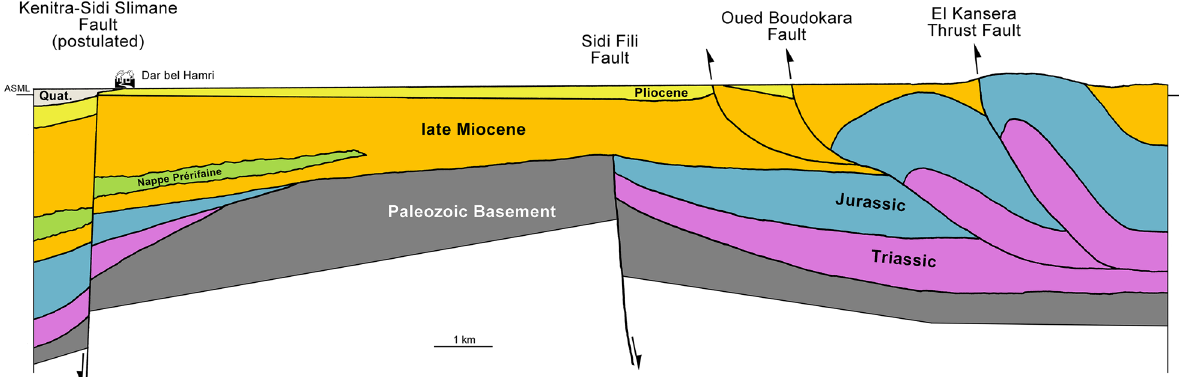
Fig. 8 Conceptual structural cross-section through studied area based on Zizi (1996) and own field observations (scale 1:1). Subsurface thicknesses are extrapolated from sections of nearby wells published in Saadi et al. (1980) and Sani et al. (2006). Subsurface positions of not-exposed tectonic elements after Tilloy (1952), Zizi (1996), and Zouhri et al.